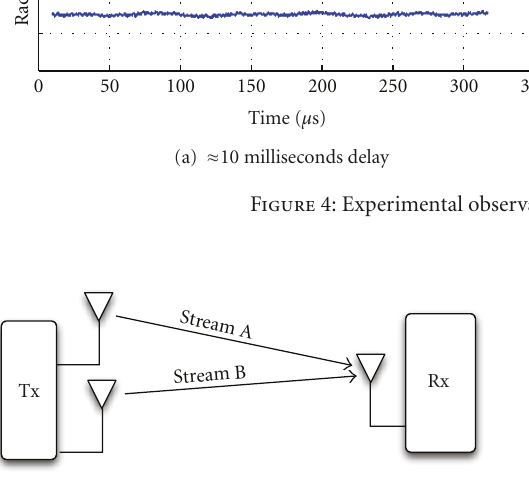
Figure 5: Equivalent 2 × 1 Alamouti